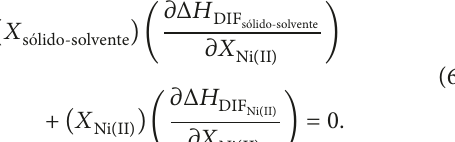
Figure 7: Ion Ni(II) differential enthalpy change in function of the carbonized surface